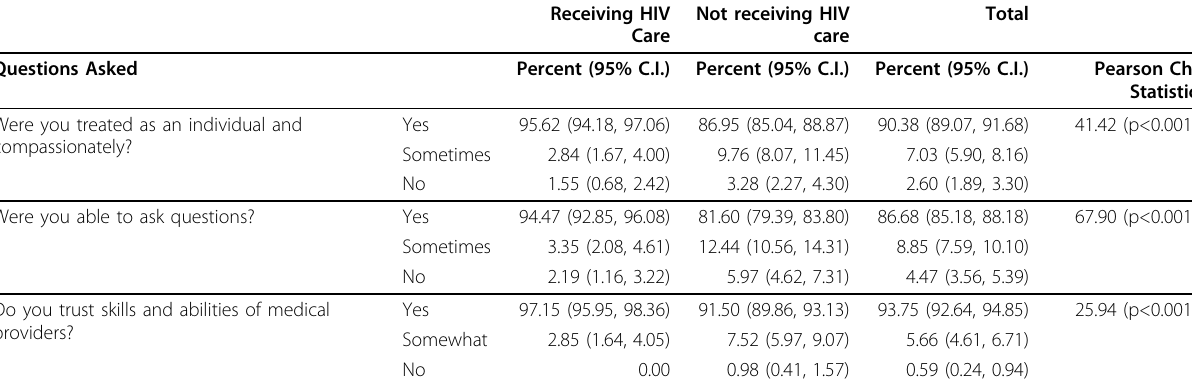
Receiving HIV Not receiving HIV Total Care care